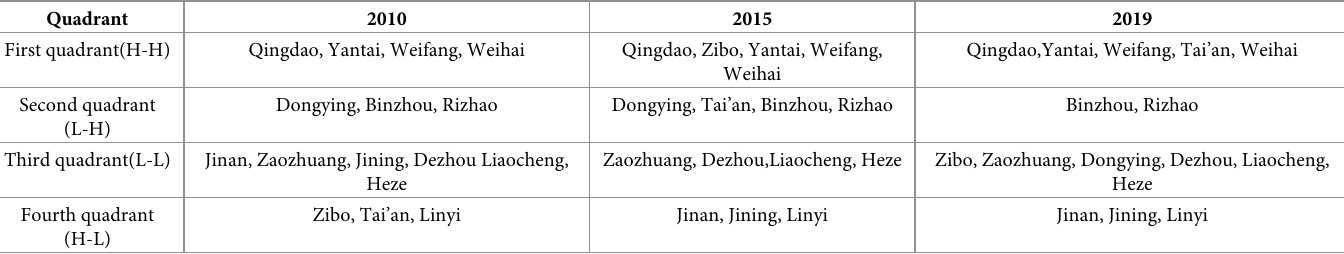
Table 4. Summary table of local Moran’s indexes scatter charts of culture and tourism integration efficiency in Shandong Province.